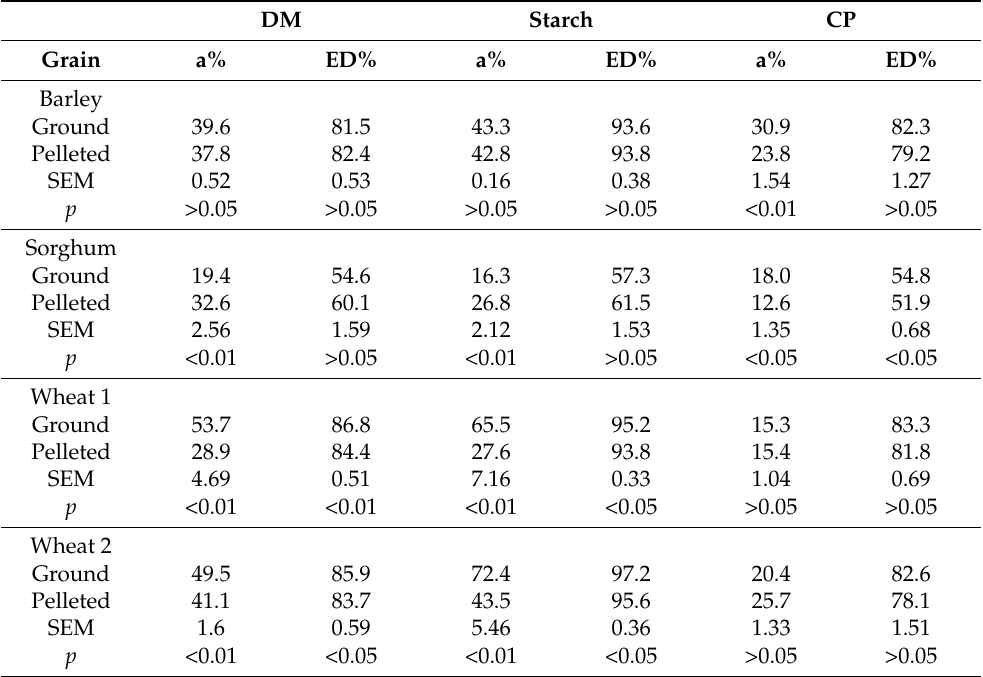
Table 3. The comparison of the rapidly degradable (a%) and the effective degradability (ED, %) between the ground and pelleted